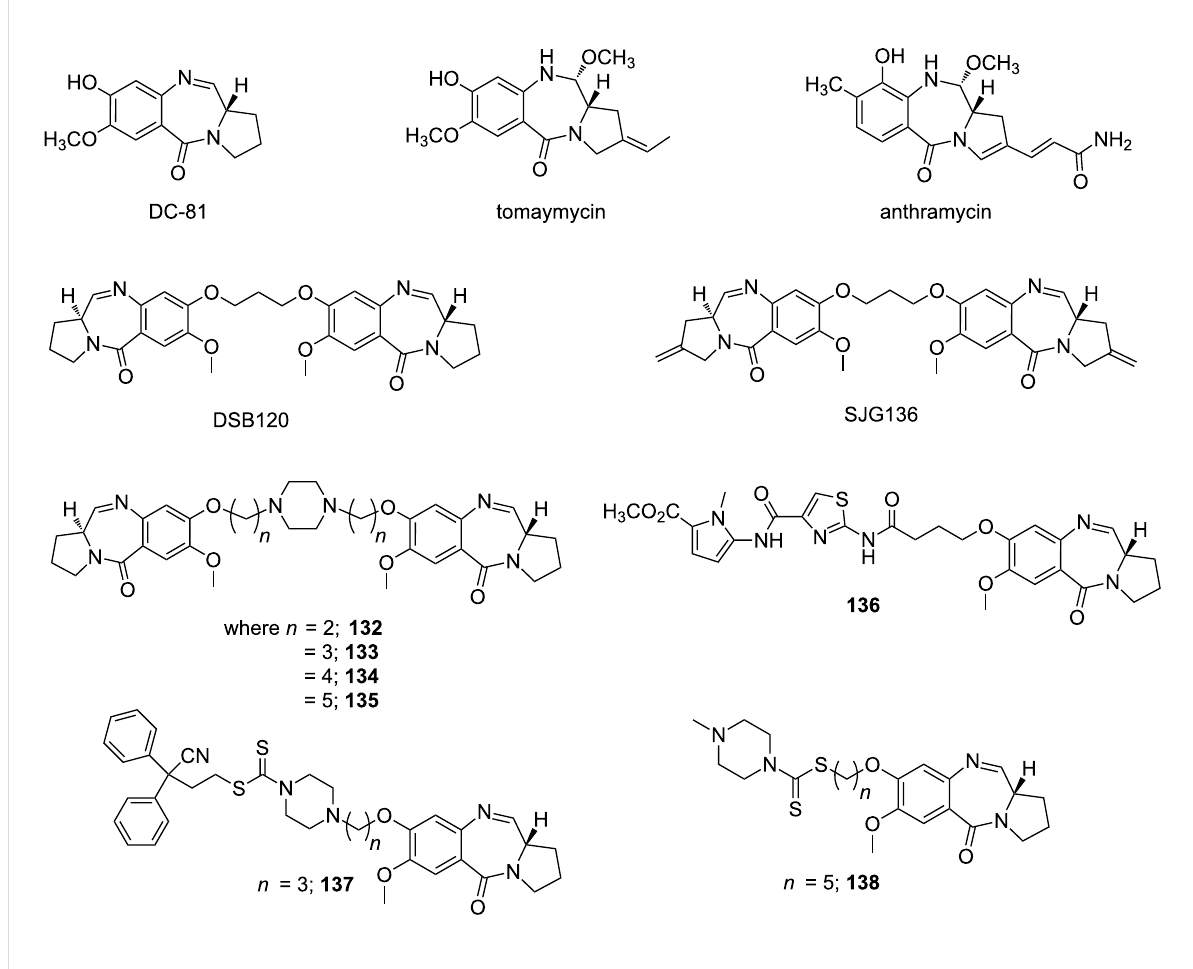
Figure 21: Chemical structures of naturally occurring and synthetic analogs of pyrrolobenzodiazepines.